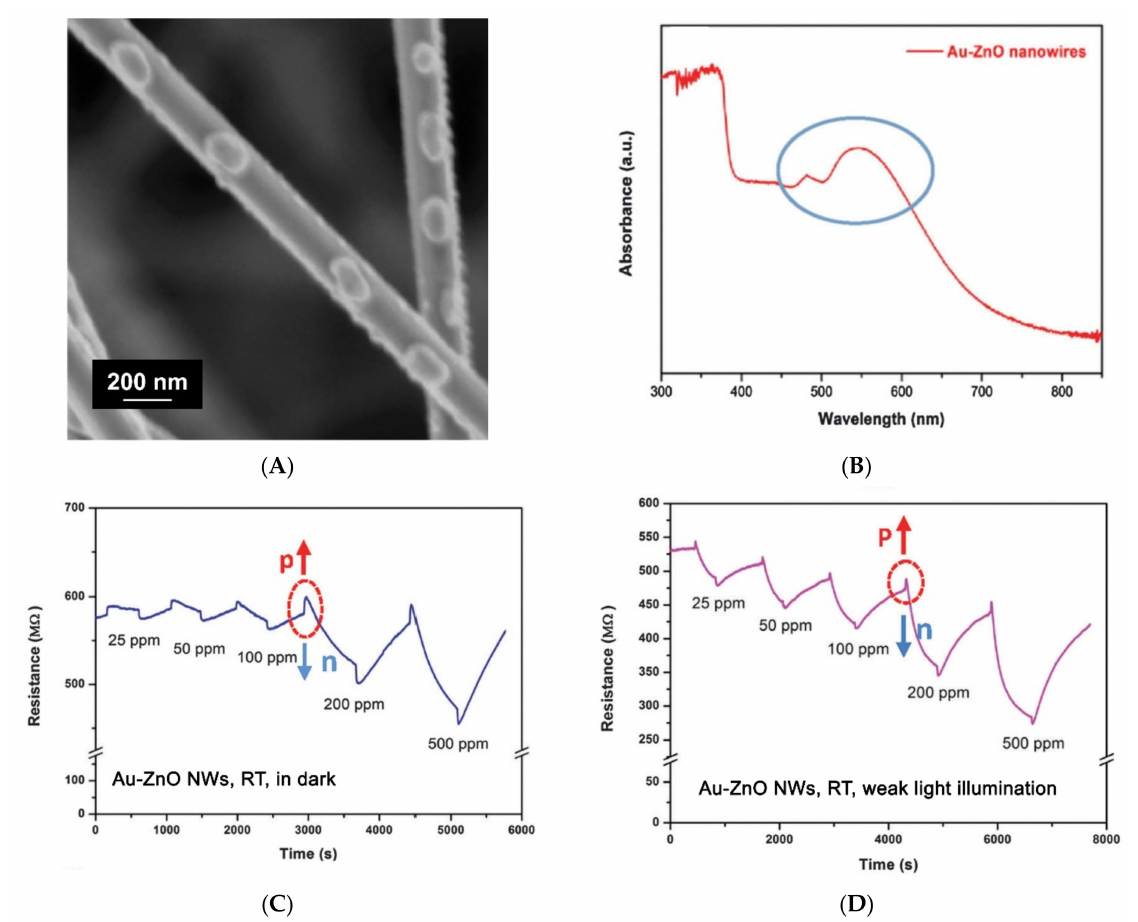
Figure 10. Electron microscopy image ( A ) and absoorbance spectrum ( B ) of ZnO/Au nanocomposite. Gas sensor measure- ments of ZnO/Au nanocomposite to acetylene in dark ( C ) and under 532 nm light illumination ( D ) and room temperature. Reprinted from [169] with permission from Royal Society of Chemistry,